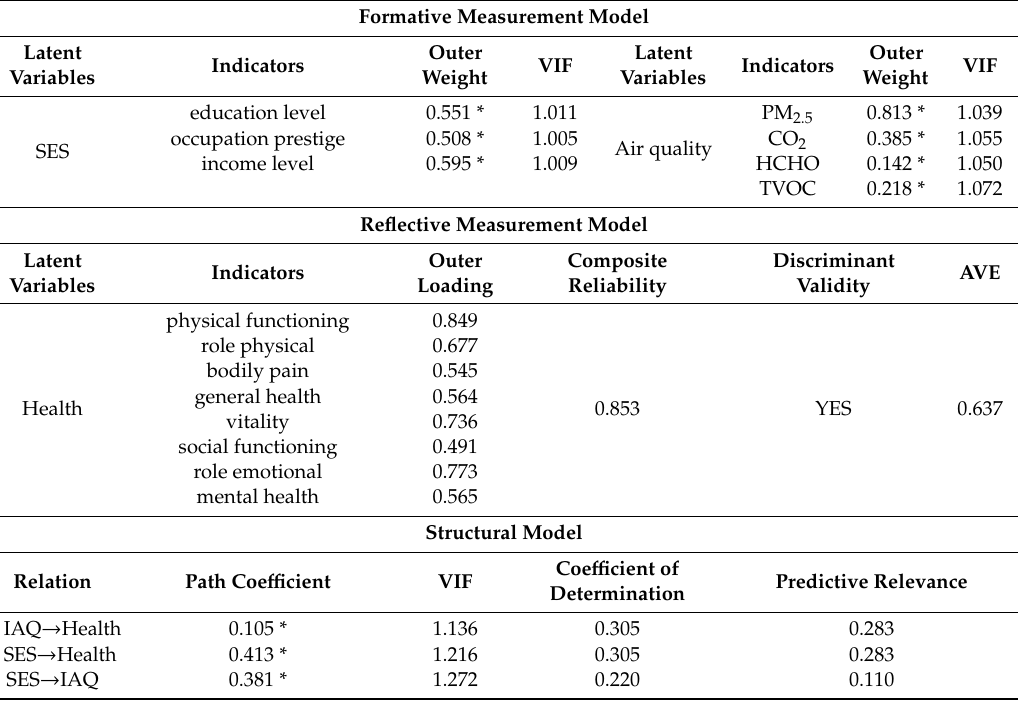
Table 4. The model evaluation results (see Figure